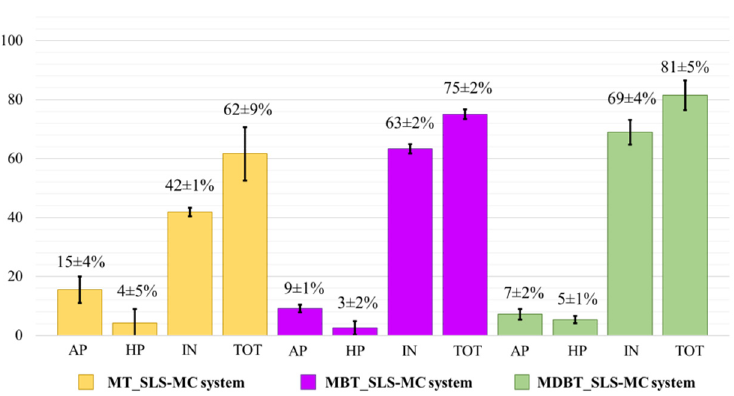
Figure 6. Comparison of quantity of active in aqueous phase (AP), hexane phase (HP) corresponding to surface-bound active (SBA), inside capsules (IN) and overall sum (TOT) for SLS-MCs containing protected thymol and derivatives. Data are presented as percentage ± standard deviation over three batches.